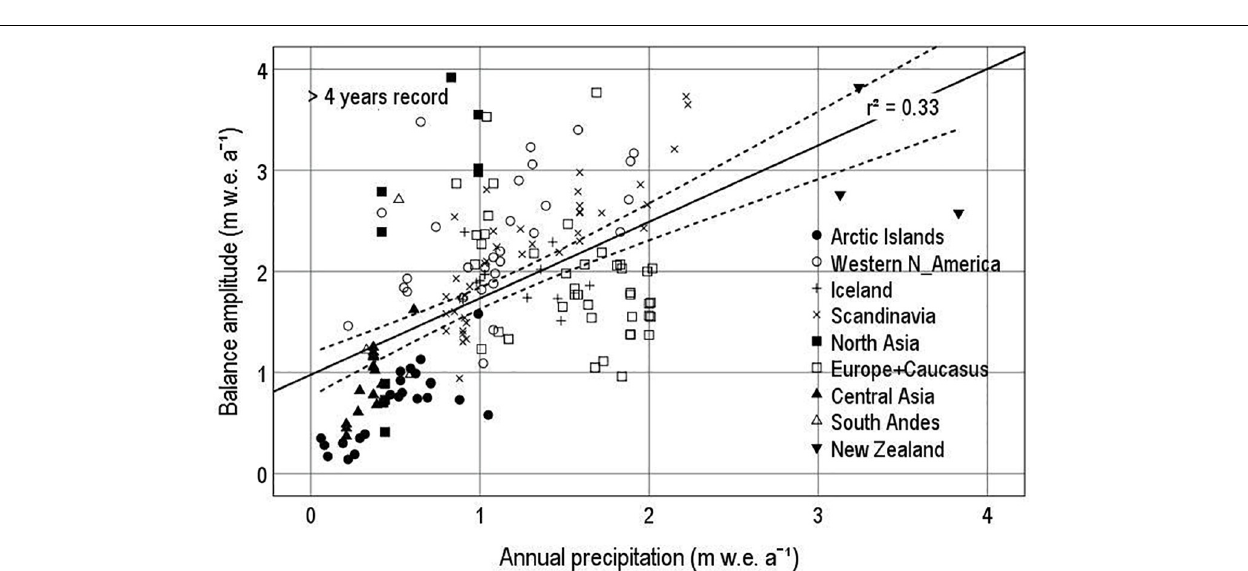
FIGURE 6 | Balance amplitude vs. annual precipitation from the Climatic Research Unit (CRU)/University of East Anglia (UEA) gridded climatology (New et al., 1999) for glaciers with > 4 years of record in 1946–2015.